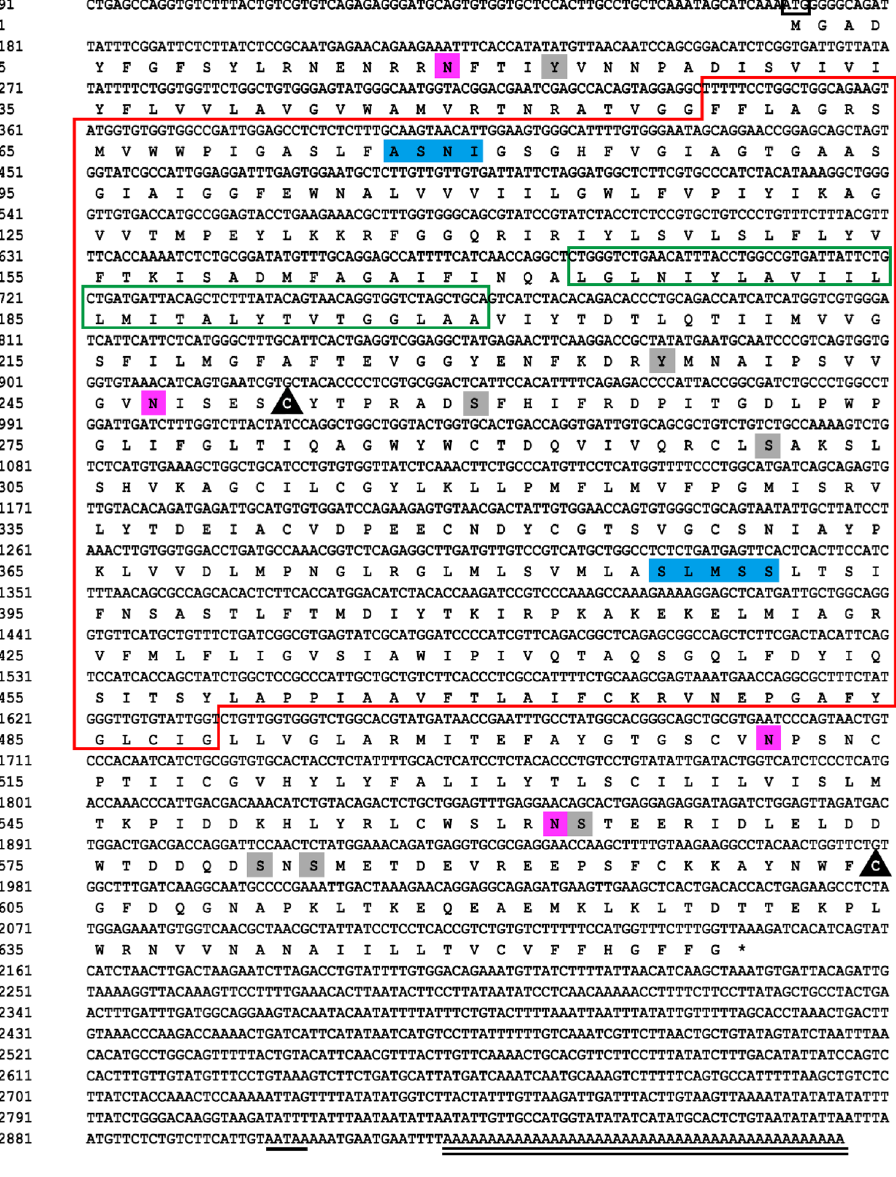
Figure 1. Sequencing results and amino acid sequence analysis of Sglt1 in Megalobrama amblycephala . The black box represents the ATG start codon; * represents the stop codon; underline represents the Poly(A) tail signal; double underline represents the poly(A) sequence; red box represents possible SSF domains (pfam00474); green box represents SSF protein characteristic conserved site NA_SOLUT_symp_1 (IPR018212); blue shadow represents Na + specific coupling sites; purple shadow represents the possible N glycosylation sites; gray shadow represents possible phosphorylation sites; black triangles represents possible disulfide bond formation